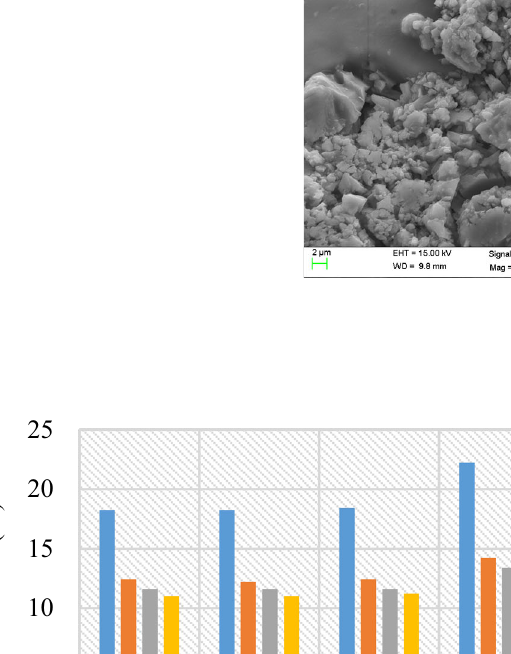
Fig. 3 SEM image of CTAB- treated XCP